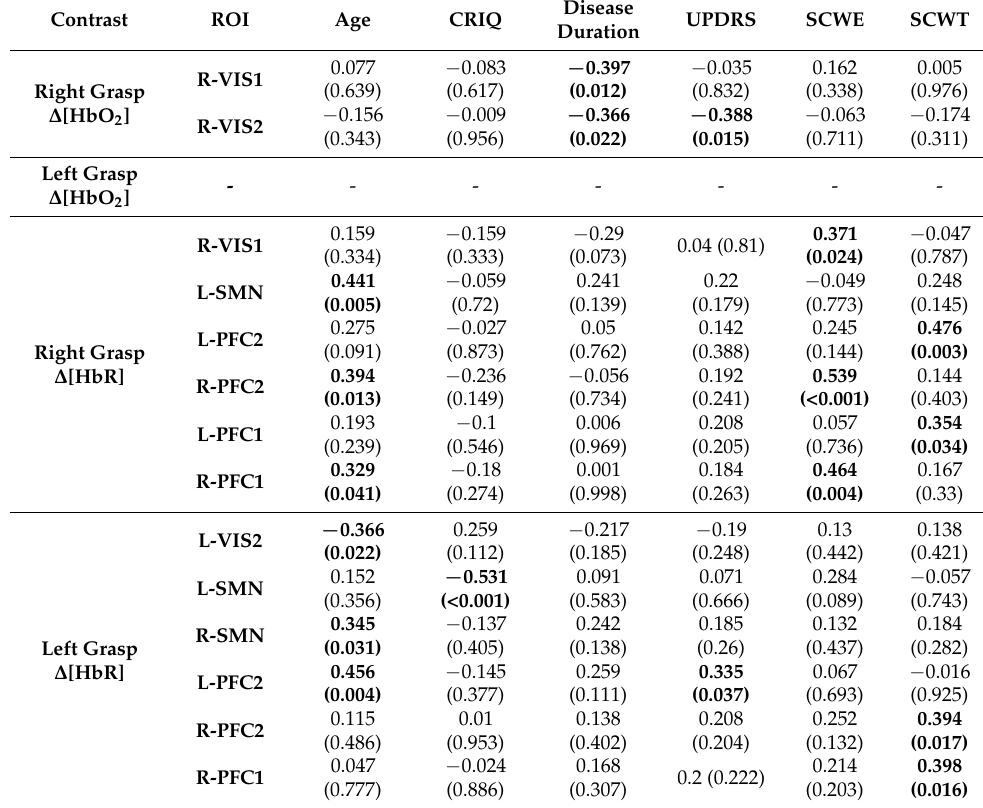
Table 4. Significant results of ROI-based correlation analysis between ROI averaged data and patient characteristics at subject level ( p < 0.05). Results are provided by means of Spearman’s correlation coefficient ρ S ( p value ). Bold highlights the significant